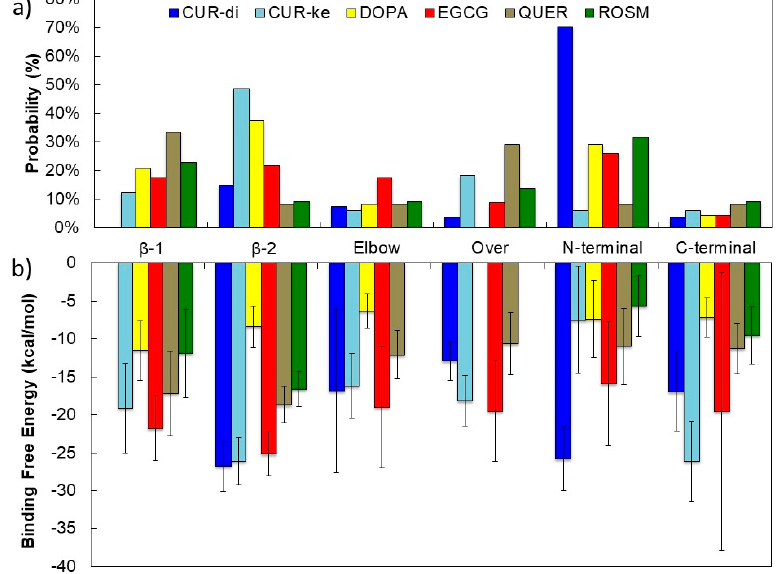
Figure 4. Probability of occupancy of each binding site ( a ) and binding free energy ( b ) for each ligand considered.